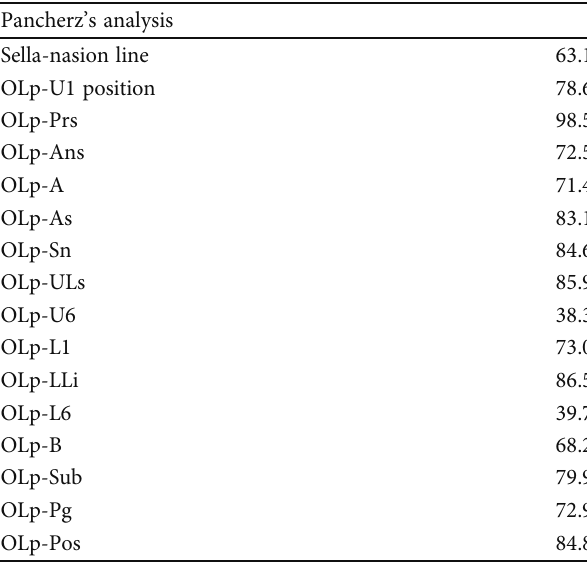
Table 3: Post-Herbst Ebo cephalometric values. Sagittal skeletal